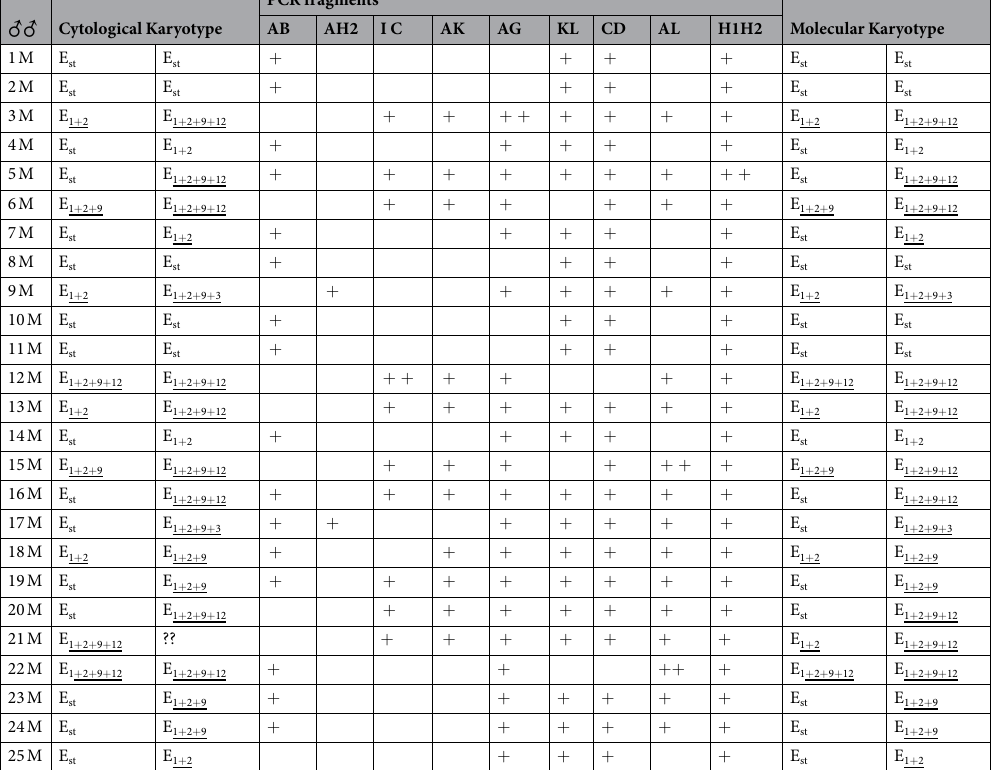
Table 1. PCR amplification results for 25 cytologically karyotyped males. The karyotype of 24 of the 25 males collected in November 2014 could be cytologically established whereas for male 21 M, only one of its E chromosome arrangements could be identified. Fragments AB, AH2 and IC are exclusive for arrangements E st , E 1 + 2 + 9 + 3 and E 1 + 2 + 9 + 12 , respectively. + , a single amplification product; ++ , two differently sized amplification products. 1 Initally, the amplification of seven PCR fragments (AB, AH2, IC, AK, AG, KL and CD) was tested in the 25 males sample. The relatively high dropout frequency of fragment AK detected in the 2015 sample led to its replacement by fragment AL, which required the additional amplification of fragment H1H2 to discern between the low-frequency karyotypes E 1 + 2 + 9 /E 1 + 2 + 9 + 3 and E 1 + 2 + 9 + 3 /E 1 + 2 + 9 + 3 (see